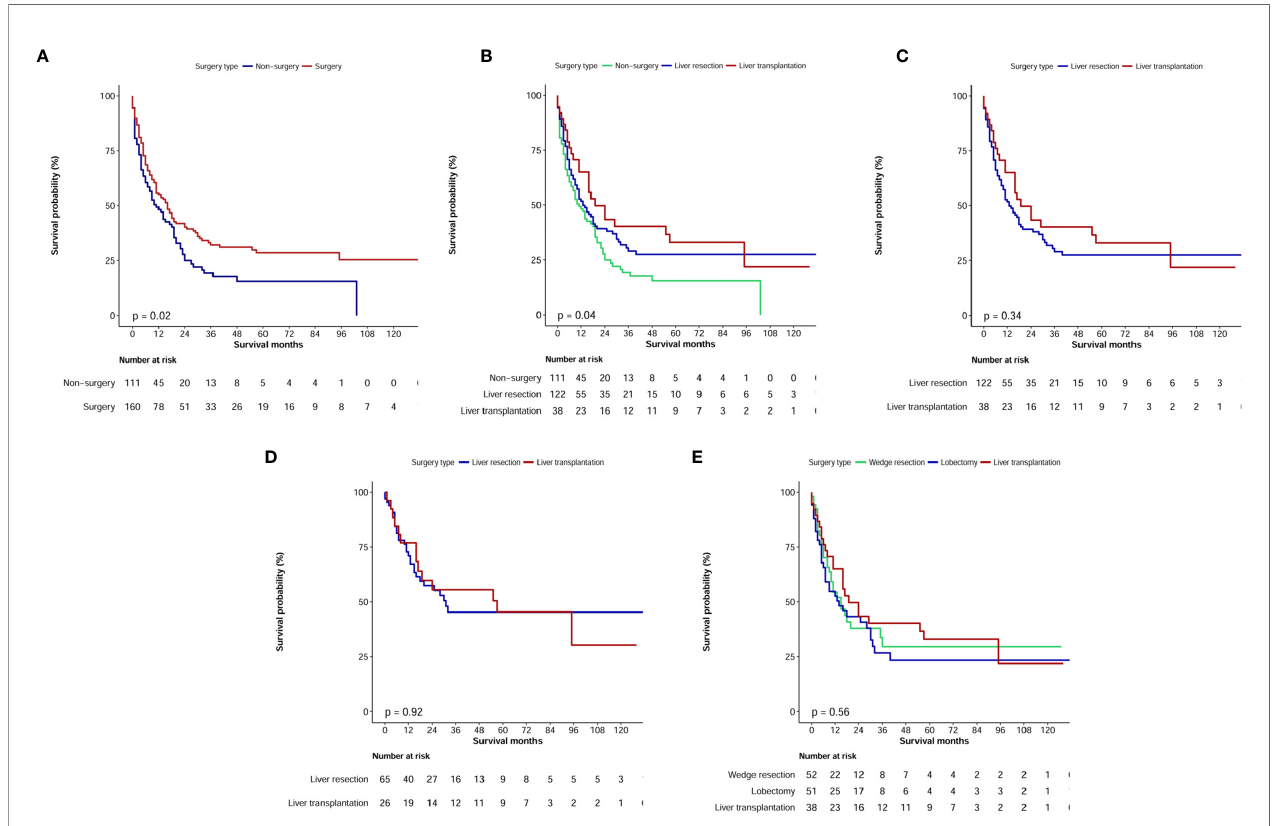
FIGURE 5 | Kaplan – Meier overall survival curves of combined hepatocellular carcinoma and cholangiocarcinoma patients with different treatment strategies. (A, B) Survival analysis of different surgery type; (C) Comparison of prognosis of patients undergoing liver resection or liver transplant before and after propensity score matching; (D) Comparison of prognosis of patients undergoing liver resection or liver transplant in TNM I+II stage; (E) Survival analysis for speci fi c surgical strategies.